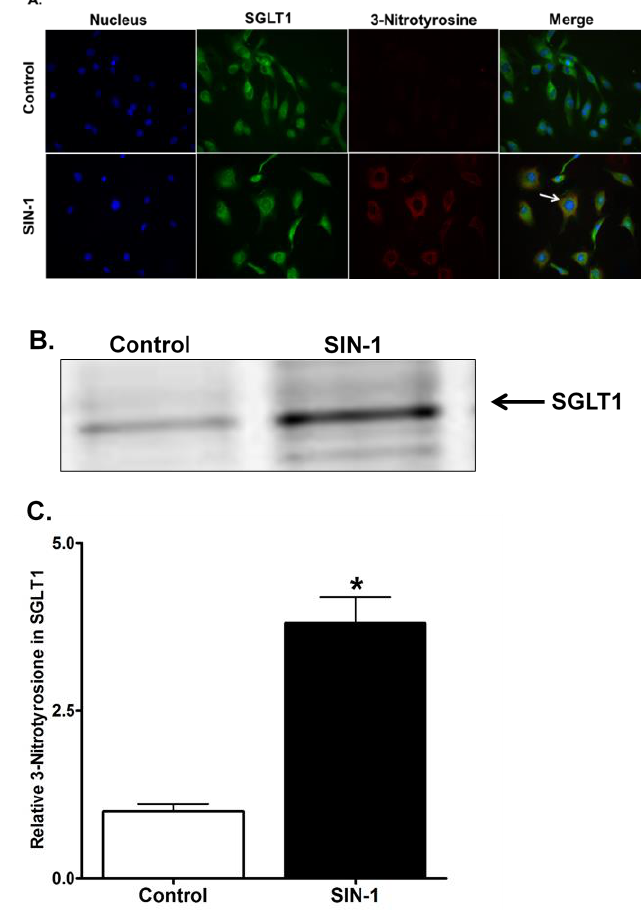
Figure 9. Peroxynitrite induced 3-NT formation in SGLT1. ( A ) Immunohistochemistry analysis reveals that SIN-1 treatment increased tyrosine nitration in IEC-18 cells compared to control. Merged picture of SGLT1 and anti-tyrosine staining showed co-localization of both the proteins. ( B ) Representative Western blot analysis of immunoprecipitated samples showing an increase in OONO induced tyrosine nitration of SGLT1 when treated with SIN-1 compared to control. ( C ) Densitometry analysis showed that the 3-NT formation was significantly increased in SGLT1 after SIN-1 treatment in IEC-18 cells (n = 4; * p < 0.05). Control is assigned a value of 1, and the SIN-1 value is relative to the